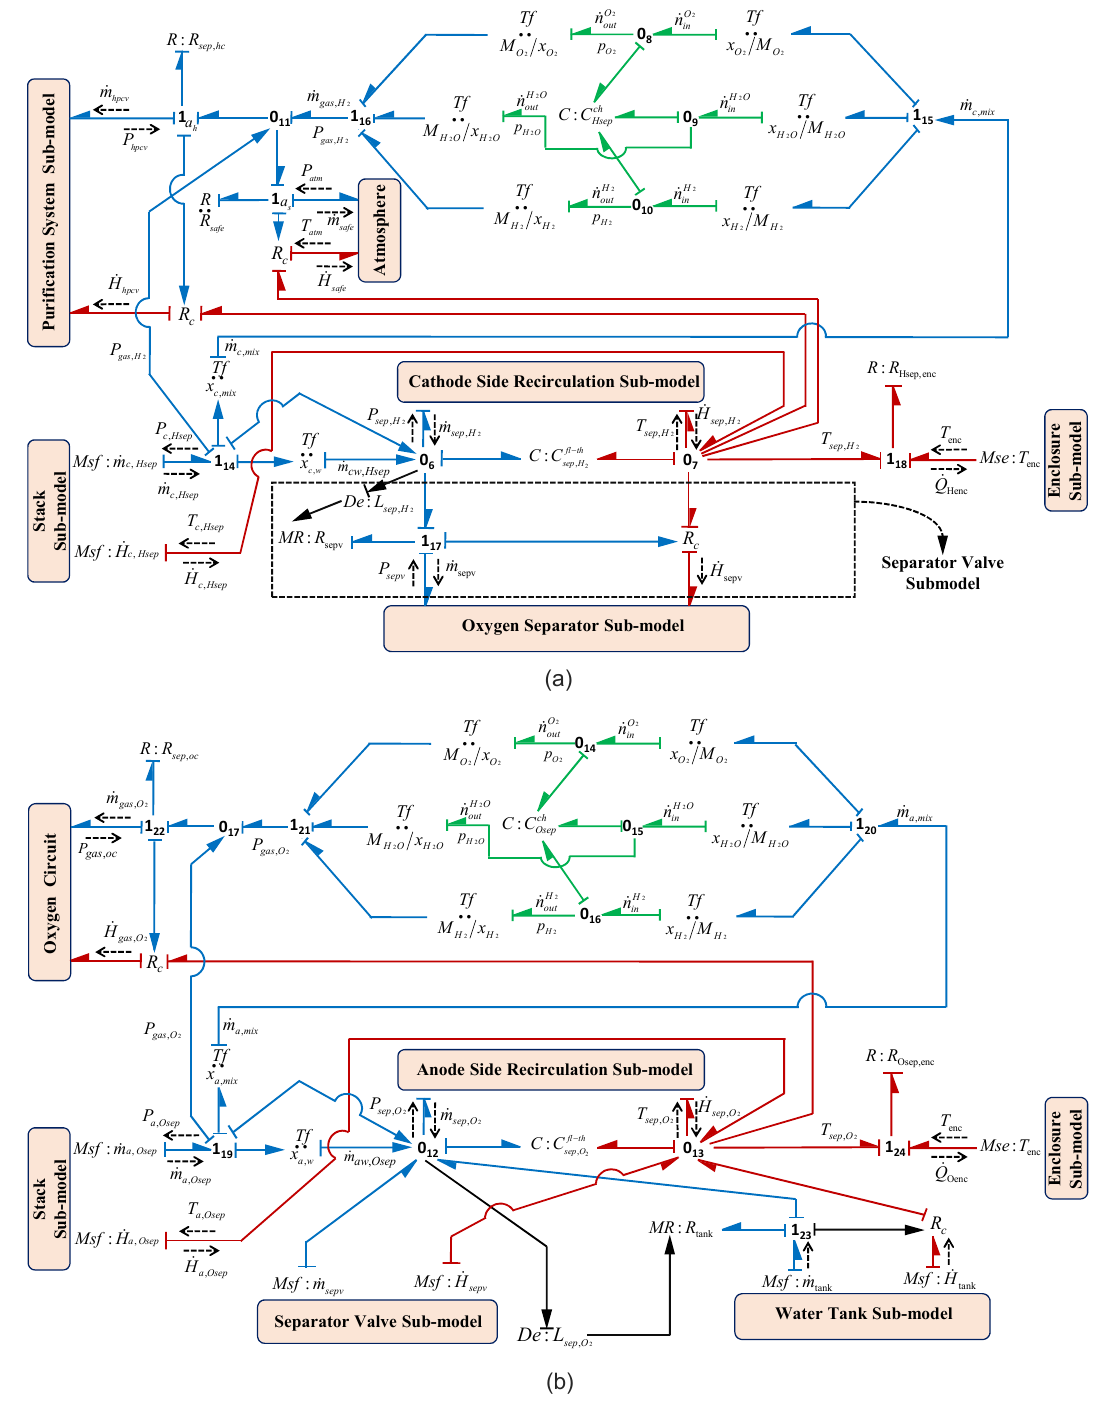
Figure 15. BG sub-models ( a ) hydrogen separator and ( b ) oxygen